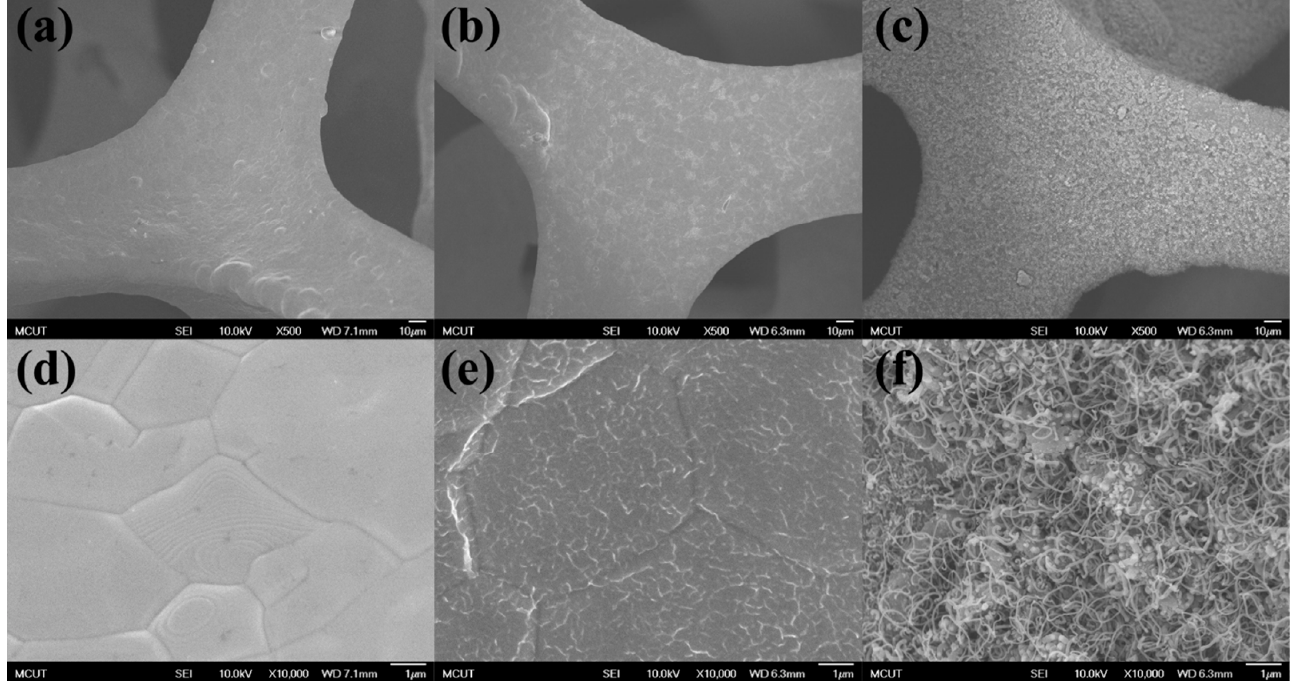
Figure 1. Low-magnification FESEM images of ( a ) NF, ( b ) Ni(OH) 2 /NF, and ( c ) CNTs/NF, respec- tively. High-magnification FESEM images of ( d ) NF, ( e ) Ni(OH) 2 /NF, and ( f ) CNTs/NF, respectively.